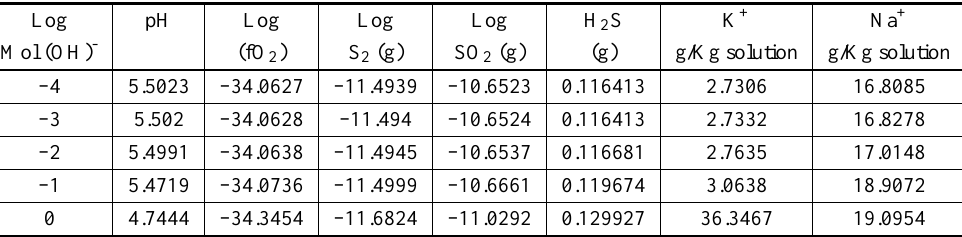
Variation in the concentration of compounds dissolved in fluid balanced with the mineral paragenesis, with the addition of KCL and (OH) − (alkalization). (Pressure in